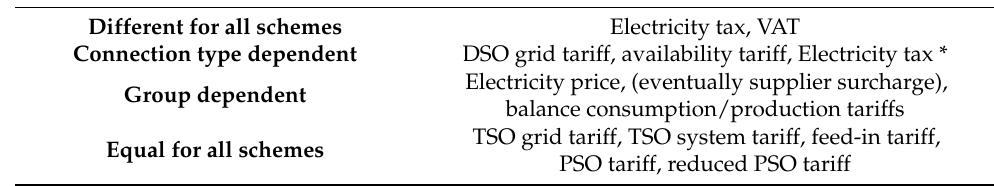
Table 6. Classification of the different tariffs and taxes according to their impact on the several schemes. Self-elaboration. Impact of the Several Tariffs and Taxes on the Total Electricity Cost Different for all schemes Electricity tax, VAT Connection type dependent DSO grid tariff, availability tariff, Electricity tax * Group